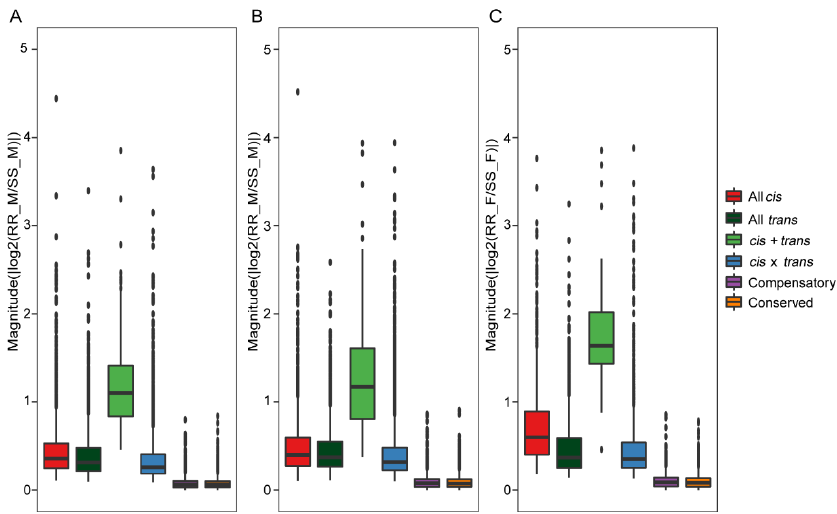
Figure 5. Expression divergence caused by regulatory patterns. ( A – C ) Boxplots showing the magnitude of expression divergence between species for genes classified as regulatory patterns in fertile F 1 hybrids (RS_M ( A ), SR_M ( B ) and SR_F ( C )), with regulatory patterns on the X -axis and a magni- tude of expression divergence on the Y -axis. Differences in regulatory patterns were significant as indicated by Wilcoxon rank-sum tests.